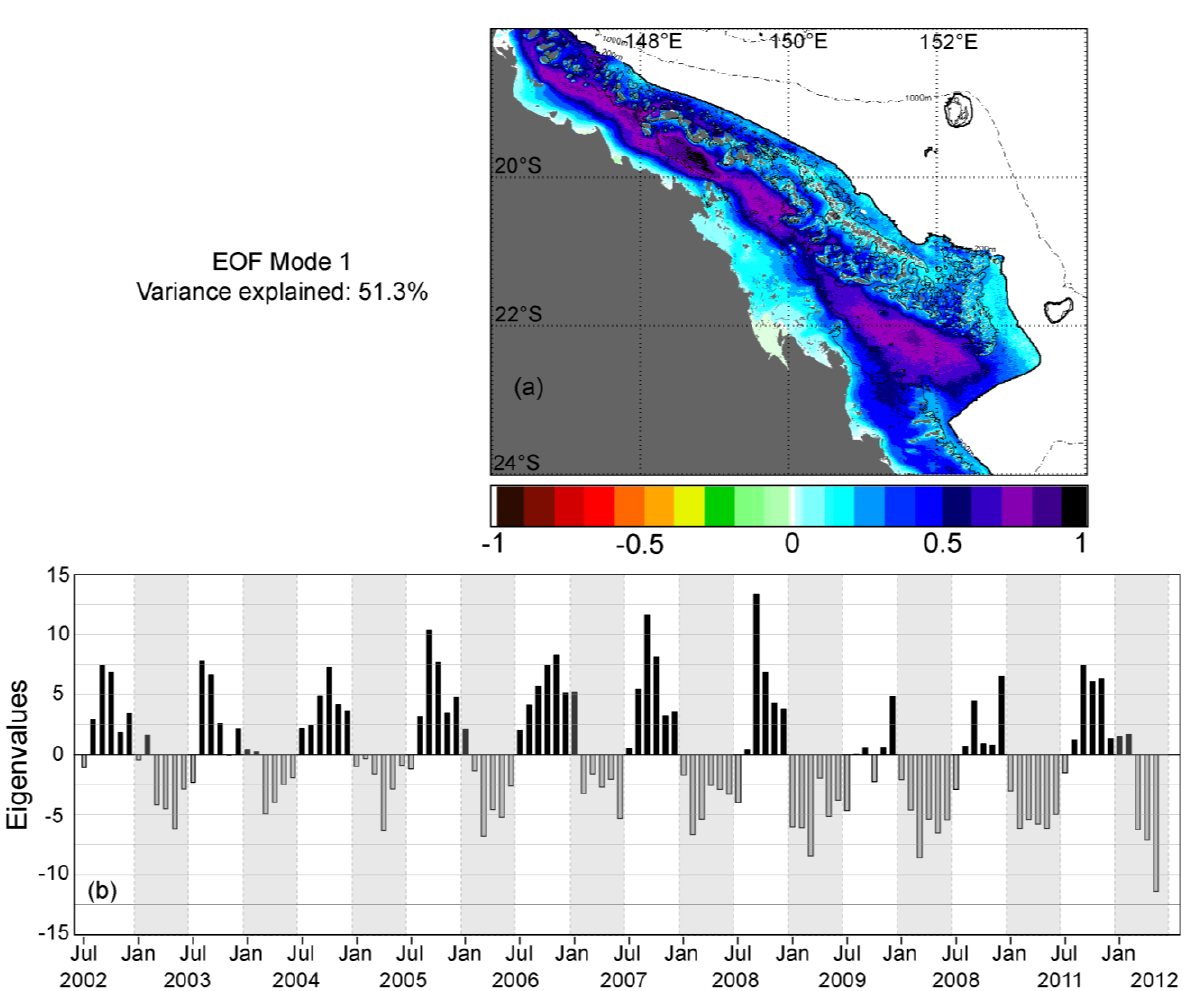
Figure 7. Mode 1 of the Empirical Orthogonal Function Analysis explaining 51.3% of the total variance of water clarity on the central-southern Great Barrier Reef from July 2002 to June 2012. The spatial pattern (panel ( a ), normalized from −1.0 to +1.0) shows a positive phase across the entire shelf with the most positive values (purple) in the mid-shelf region. Panel ( b ) provides the temporal variation associated with the spatial pattern over the 10-year